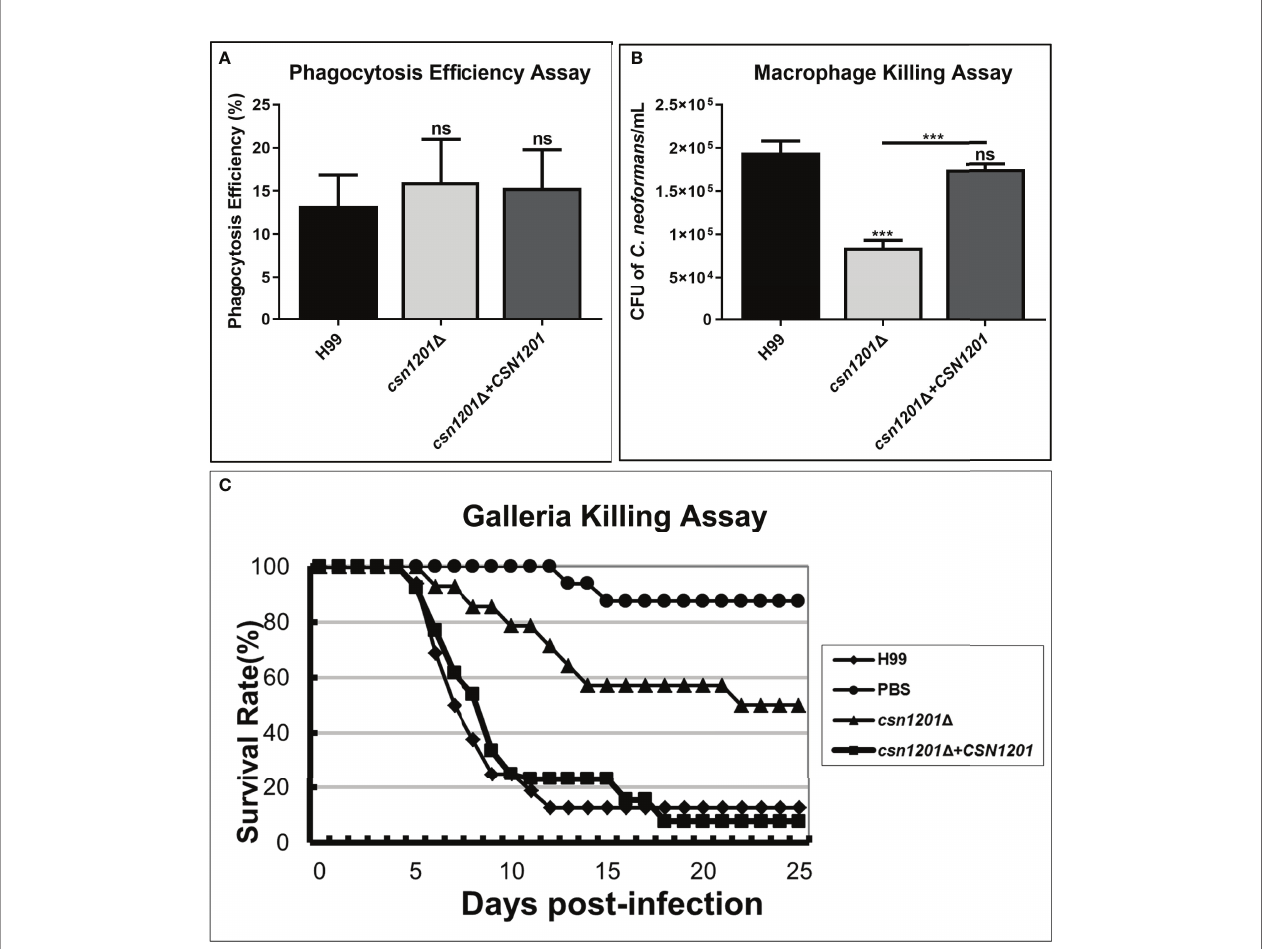
FIGURE 3 | Csn1201 is required for cryptococcal survival in macrophages and in Galleria mellonella . Macrophage phagocytosis (A) and killing (B) assays. Activated macrophages were coincubated with 10 6 cryptococcal cells for 2 h to allow phagocytosis. Extracellular yeasts were removed, diluted, and cultured on YPD plates for 3 days. Macrophages were lysed with 0.05% SDS and intracellular (attached and digested) yeasts were determined on YPD plates after 3 days of growth. Phagocytosis ef fi ciency was calculated using the formula (intracellular cells/[intracellular cells + extracellular cells] × 100%). A similar method was used to calculate cryptococcal survival inside the macrophage after 24 h of coincubation. Each strain was tested in triplicate. ***, P < 0.001; ns, no signi fi cant difference. (C) In vivo virulence assay in the G. mellonella